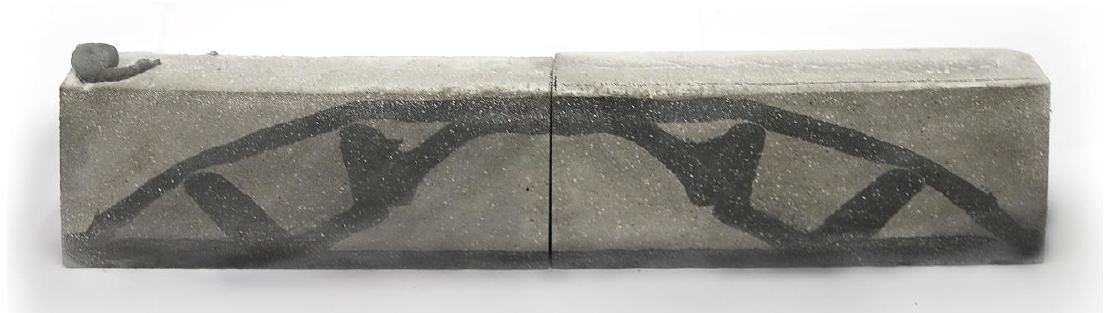
Figure 15. Longitudinal section through the CiC sample.